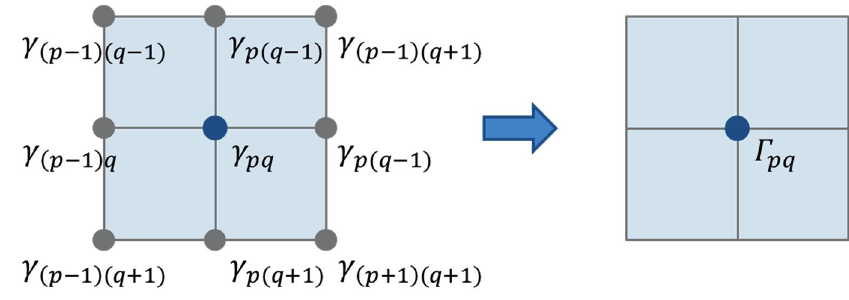
Figure 2. Schematic view of the new